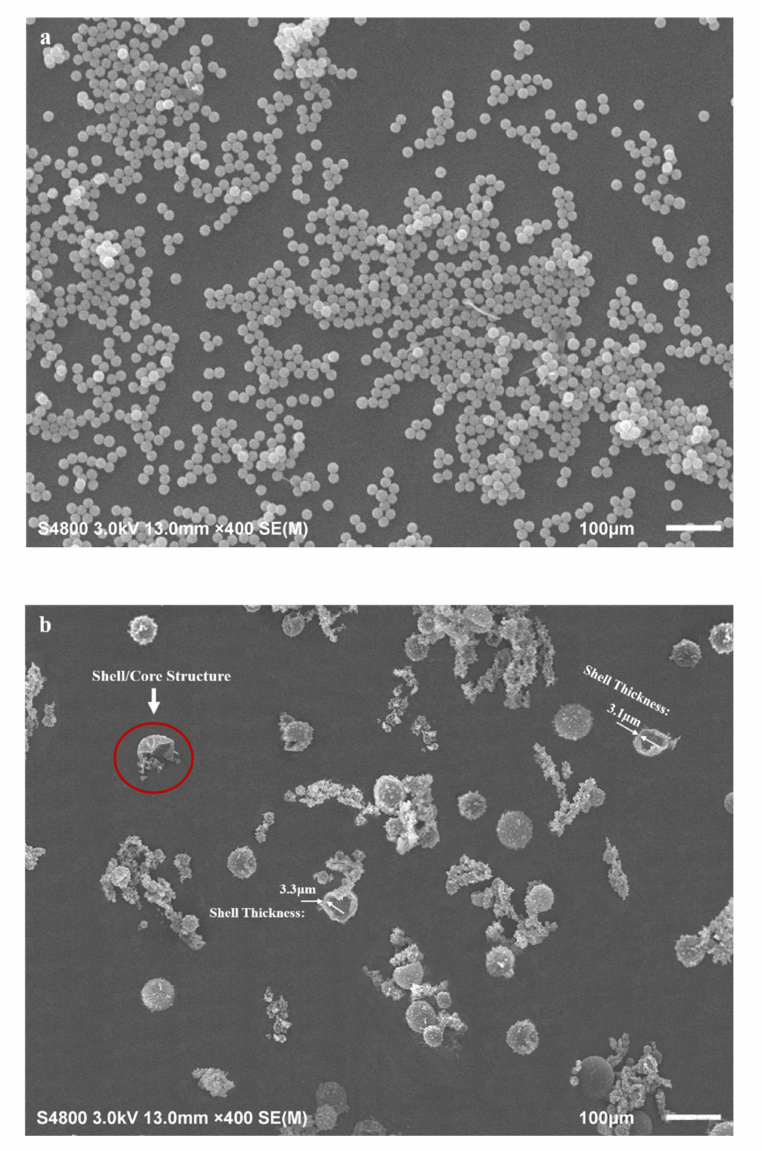
Figure 5. SEM images of microcapsules: ( a ) WM1, ( b )